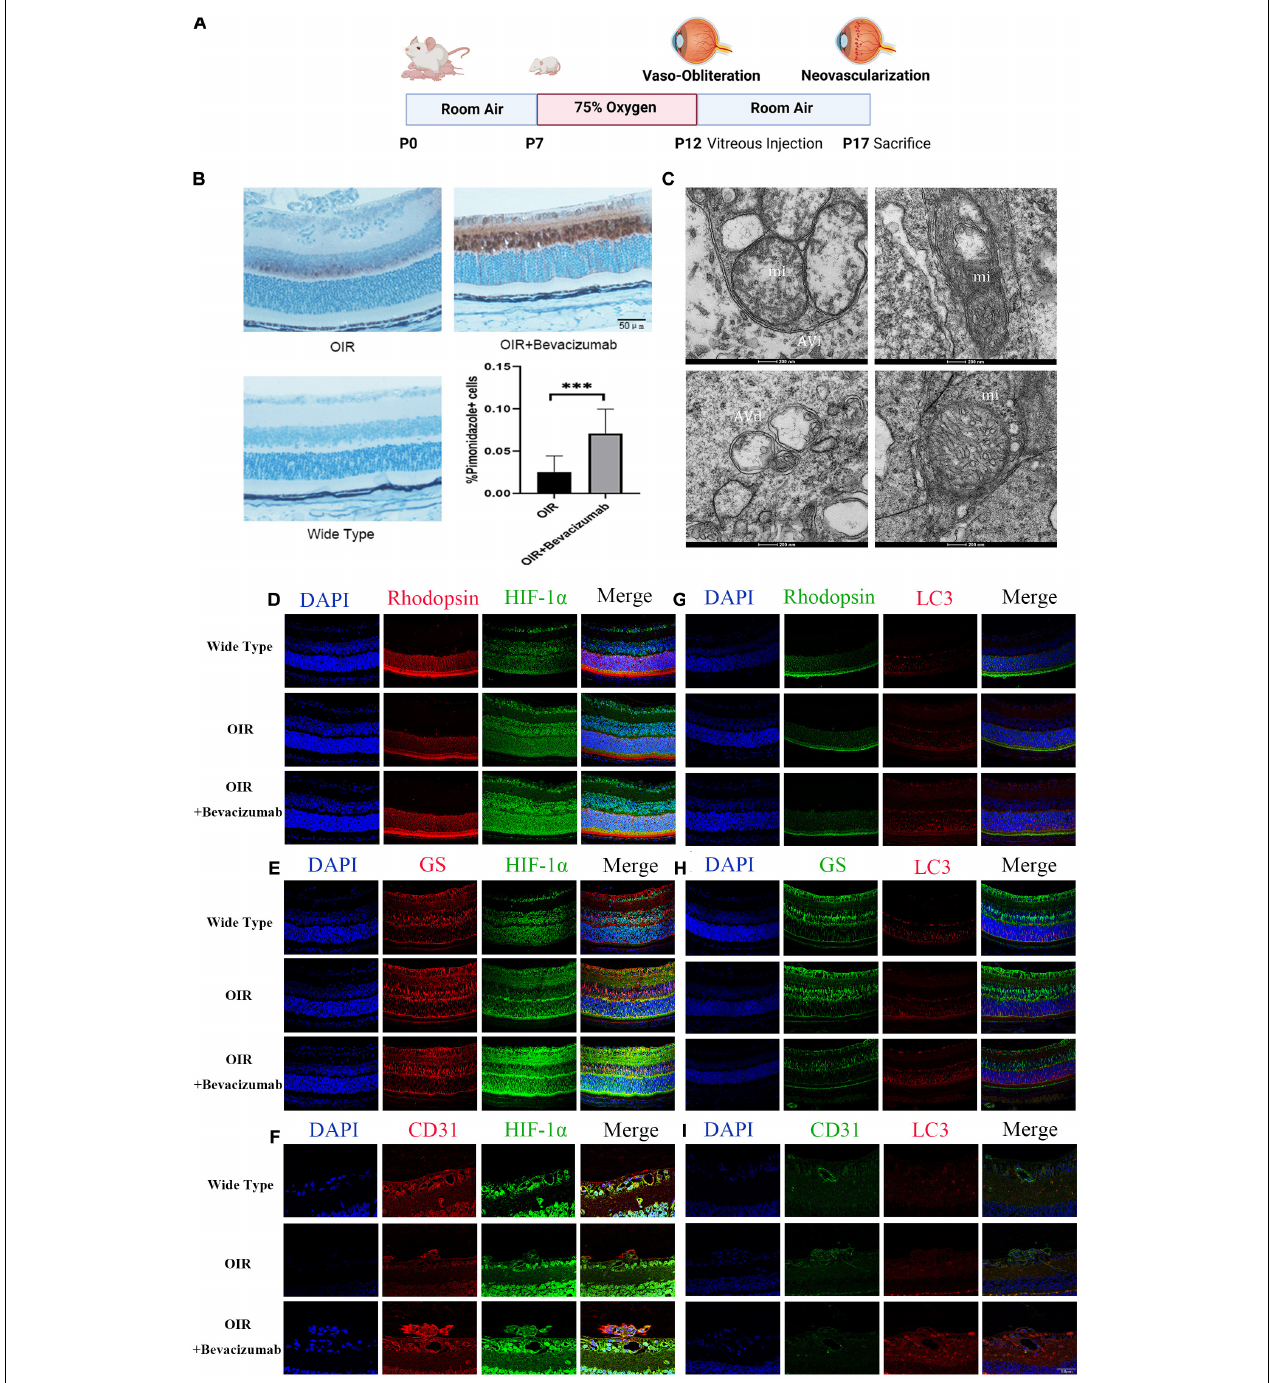
FIGURE 2 | Bevacizumab exacerbated hypoxia and increased HIF-1 α expression and autophagy in photoreceptors, Müller cells, and vascular endothelial cells of OIR model retina. (A) A time line schematic of oxygen-induced retinopathy (OIR) modeling. (B) Pimonidazole staining images and quantification showed more serious hypoxia within the retinal tissue after injected with bevacizumab in OIR mice. Bar = 50 µ m. (C) Representative transmission electron microscopy (TEM) images depicting mitochondria, mitophagosomes, and mitolysosomes. In OIR mouse treated with bevacizumab, autophagosomes, referred as initial autophagic vacuoles (Avi) have double membrane contain mitochondria (mi) (upper left). Late and Degenerative autophagic vacuoles (Avd) have mitochondria at various stages of degradation (upper right and lower left), which have different morphology of mitochondria with normal mitochondria (lower right). Bar = 200 nm. (D–F) Representative dual immunofluorescence images showing HIF-1 α accumulation in photoreceptors (rhodopsin-positive), Müller cells (glutamine synthetase-positive) and vascular endothelial cells (CD31-positive) following intravitreal injection of bevacizumab. Bar = 50 µ m. (G–I) Representative dual immunofluorescence images showing LC3 upregulation in photoreceptors, Müller cells, and vascular endothelial cells following intravitreal injection of bevacizumab. Bar = 50 µ m. ns: no significance, * P < 0 . 05, ** P < 0 . 01, *** P < 0.001.